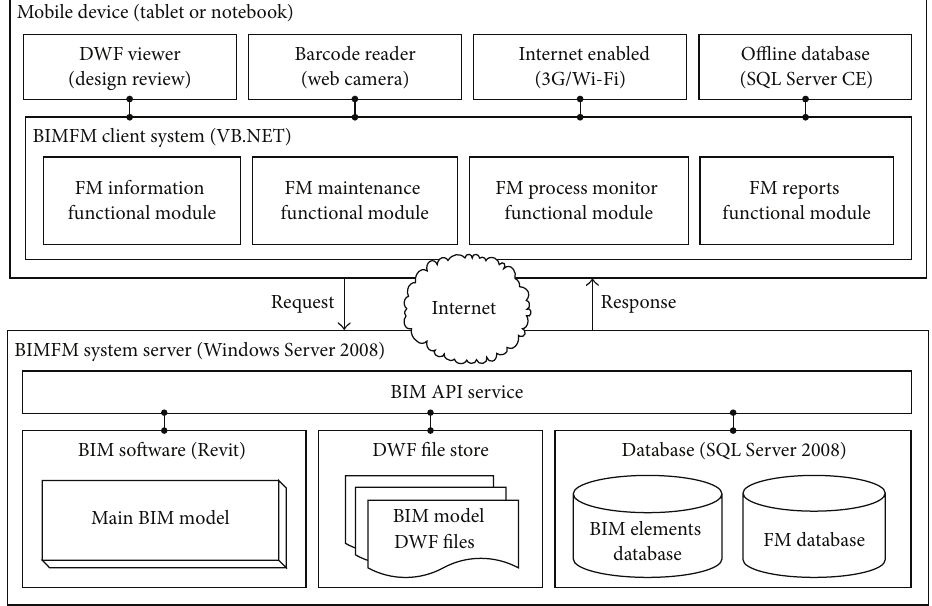
Figure 1: Overview of the BIMFM system